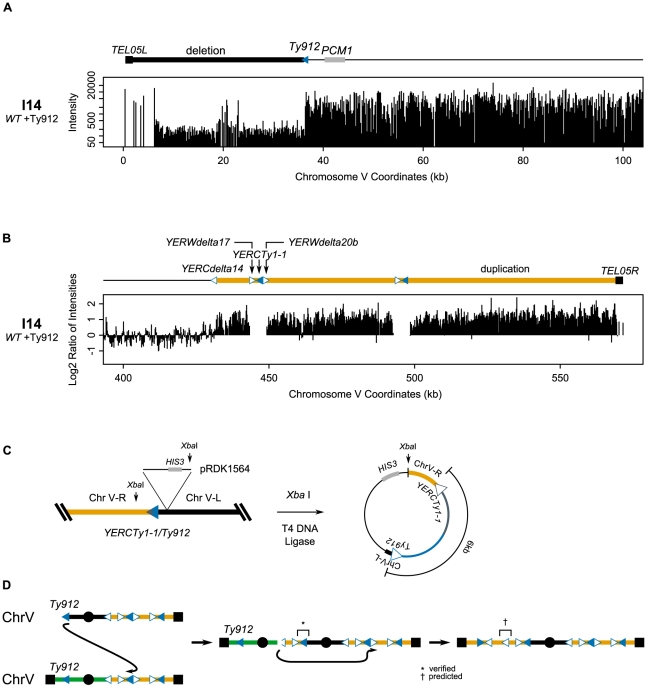
The dicentric structure of isolate I14 is resolved by Ty-mediated recombination.A. Deletion of the region between TEL05L and Ty912 in isolate I14. B. Duplication of the region between YERCdelta14 and TEL05R. C. Schematic of the integration of pRDK1564 near the fusion junction and subsequent steps utilized to create a vector cloning the fusion junction. The Ty fusion junction measures approximately 6 kb, the size of one full length Ty1 element. D. Exposed Ty912 DNA invades YERCTy1-1, copying through the centromere and creating a dicentric chromosome. The unstable dicentric chromosome breaks at YERCdelta14 and invades YERWdelta20b, copying the rest of the duplicated region to TEL05R. * is a verified junction; † a predicted junction.